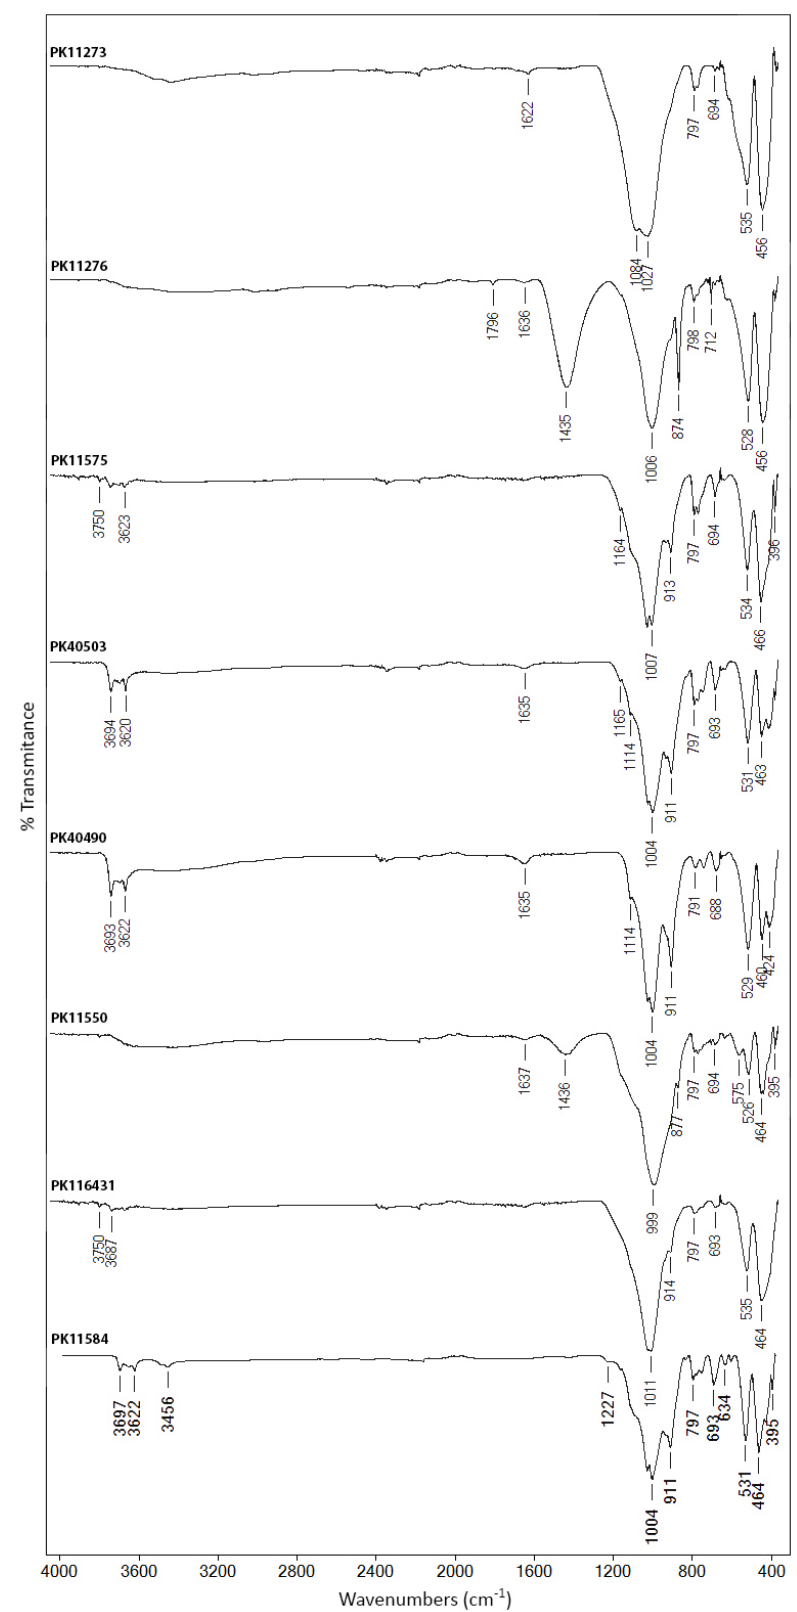
Figure 1. FTIR spectra registered on the red ochers.